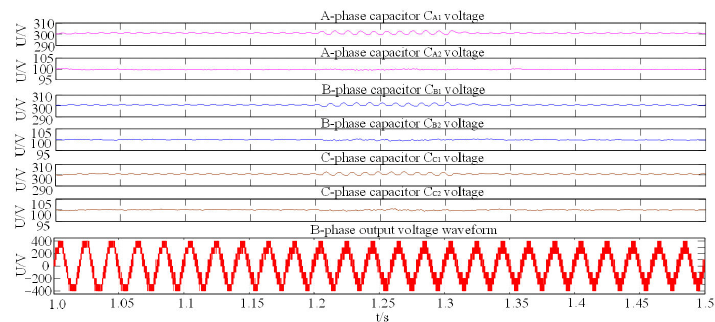
Figure 19. Waveform of capacitor voltage and B-phase output